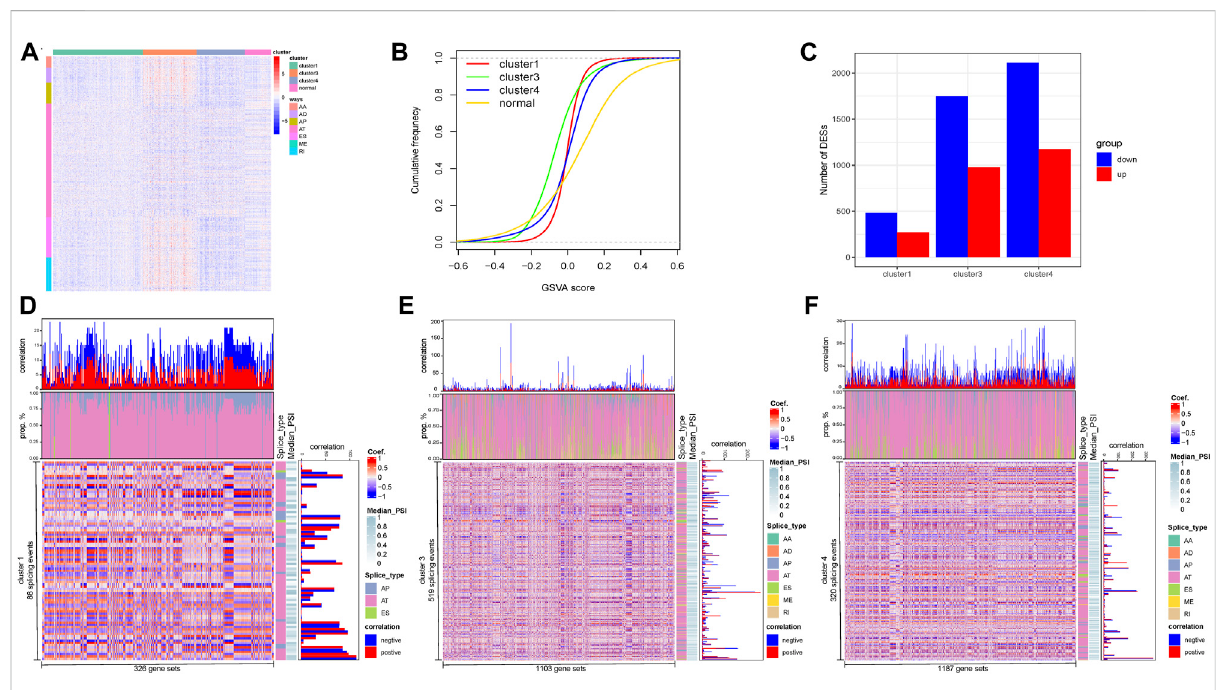
FIGURE 3 Analysis of DASEs Corresponding Genes and Alternative Splicing Events and GSVA Analysis. (A) Heat map of DASEs corresponding gene expression. (B) Statistics of the number of differential enrichment pathways of each subtype compared with normal samples. (C) We exploited a Nomogram to evaluate the prognosis of HCC with prediction model of POLD1 expression and pTNM stage. (D – F) Display of strong correlation between differential gene sets and alternative splicing